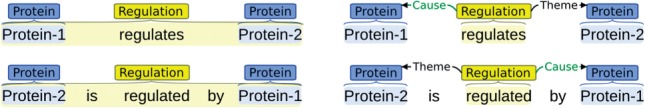
Span versus structure. Although a representation using nested, typed spans (left) can capture the fact that specific entities participate in a process, it lacks the mechanisms to express, e.g. the direction of causality. The structured event representation (right) differentiates Themes from Causes